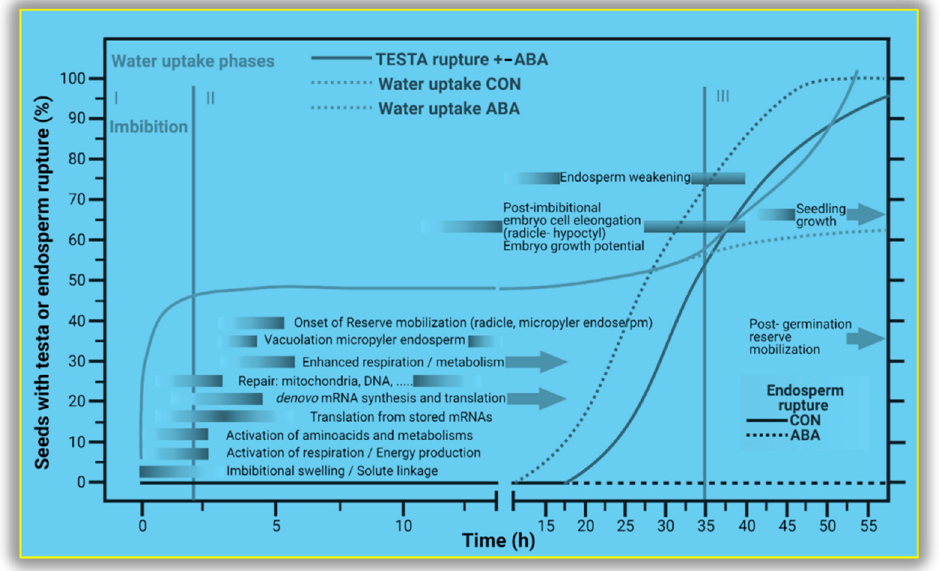
Figure 4. Timeline of crucial processes during the germination of eudicot seeds that exhibit separate testa and endosperm rupture (two-step germination). Water uptake, testa and endosperm rupture, and the effect of ABA on these processes are shown for Arabidopsis thaliana seed; control and without hormone CON. Critical biochemical, biophysical, and cellular events during germination are triggered by water uptake and are shown in the diagram. Water uptake phases: Imbibition (I), Post-imbibition (II), and Post germination reserve mobilization (III) . The diagram is based on the understanding from [152–155].